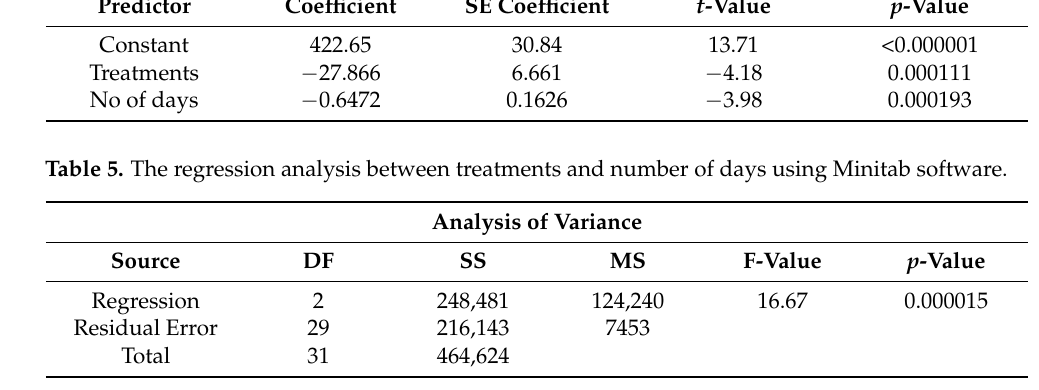
Figure 3. The difference in the degradation of TPH with respect to time (No. of days) in treatments (T1–T7) and (T0). The values are the mean and standard error ± of three replicates. 4. Discussion A limitation in bioremediation revealed the contention that the complete remediation of petroleum waste contaminated soils requires some additional accelerators with nontoxic characteristics and a large surface area [27,28]. AgNPs, because of their environmental feasibility, ecologically sound behavior, and availability of large surface area for microbes, were known to remediate industrial wastewater [29–32]. However, studies related to the use of AgNPs to remediate petroleum waste contaminated soils provide inconsistent findings. The present study shows that AgNPs application alone at 1.5 mg/kg concentration to petroleum waste contaminated soils does not positively or negatively affect the bacterial population and cannot accelerate the degradation of TPHs.